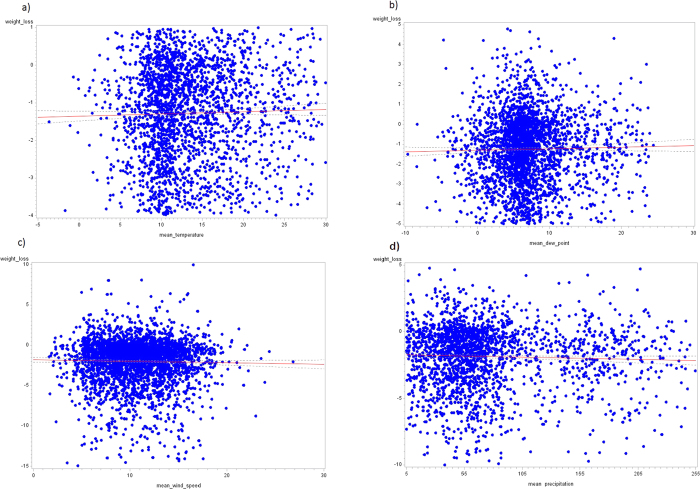
Scatter plots of weight loss and weather factors.*Weight loss: final BMI – initial BMI for each user, mean climatic value: average of the climatic values for each user and 95% CI (a) average temperature vs. weight loss, (b) average dew point vs. weight loss, (c) average wind speed vs. weight loss, (d) average precipitation vs. weight loss). The English in this document has been checked by at least two professional editors, both native speakers of English. For a certificate, please see: http://www.textcheck.com/certificate/SJ2UB2.